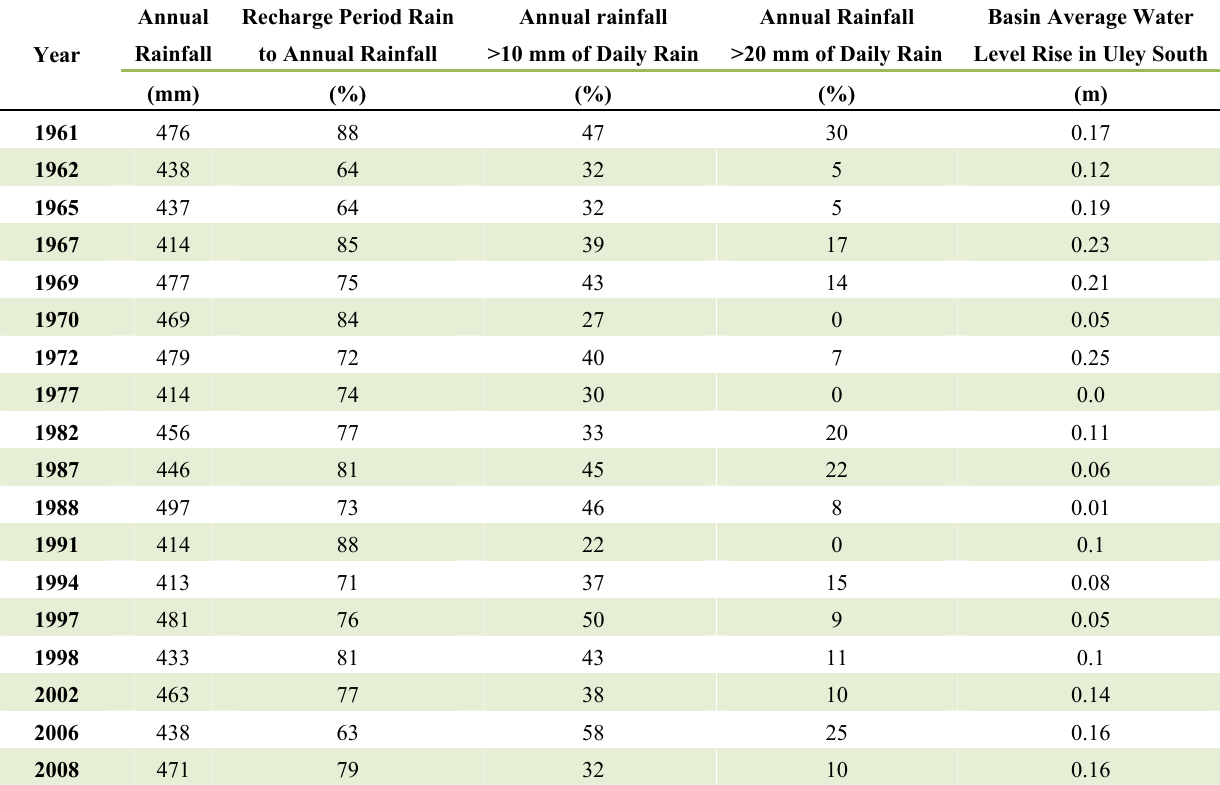
Table 1. Basin average water level response in Uley South to below average annual rainfall.